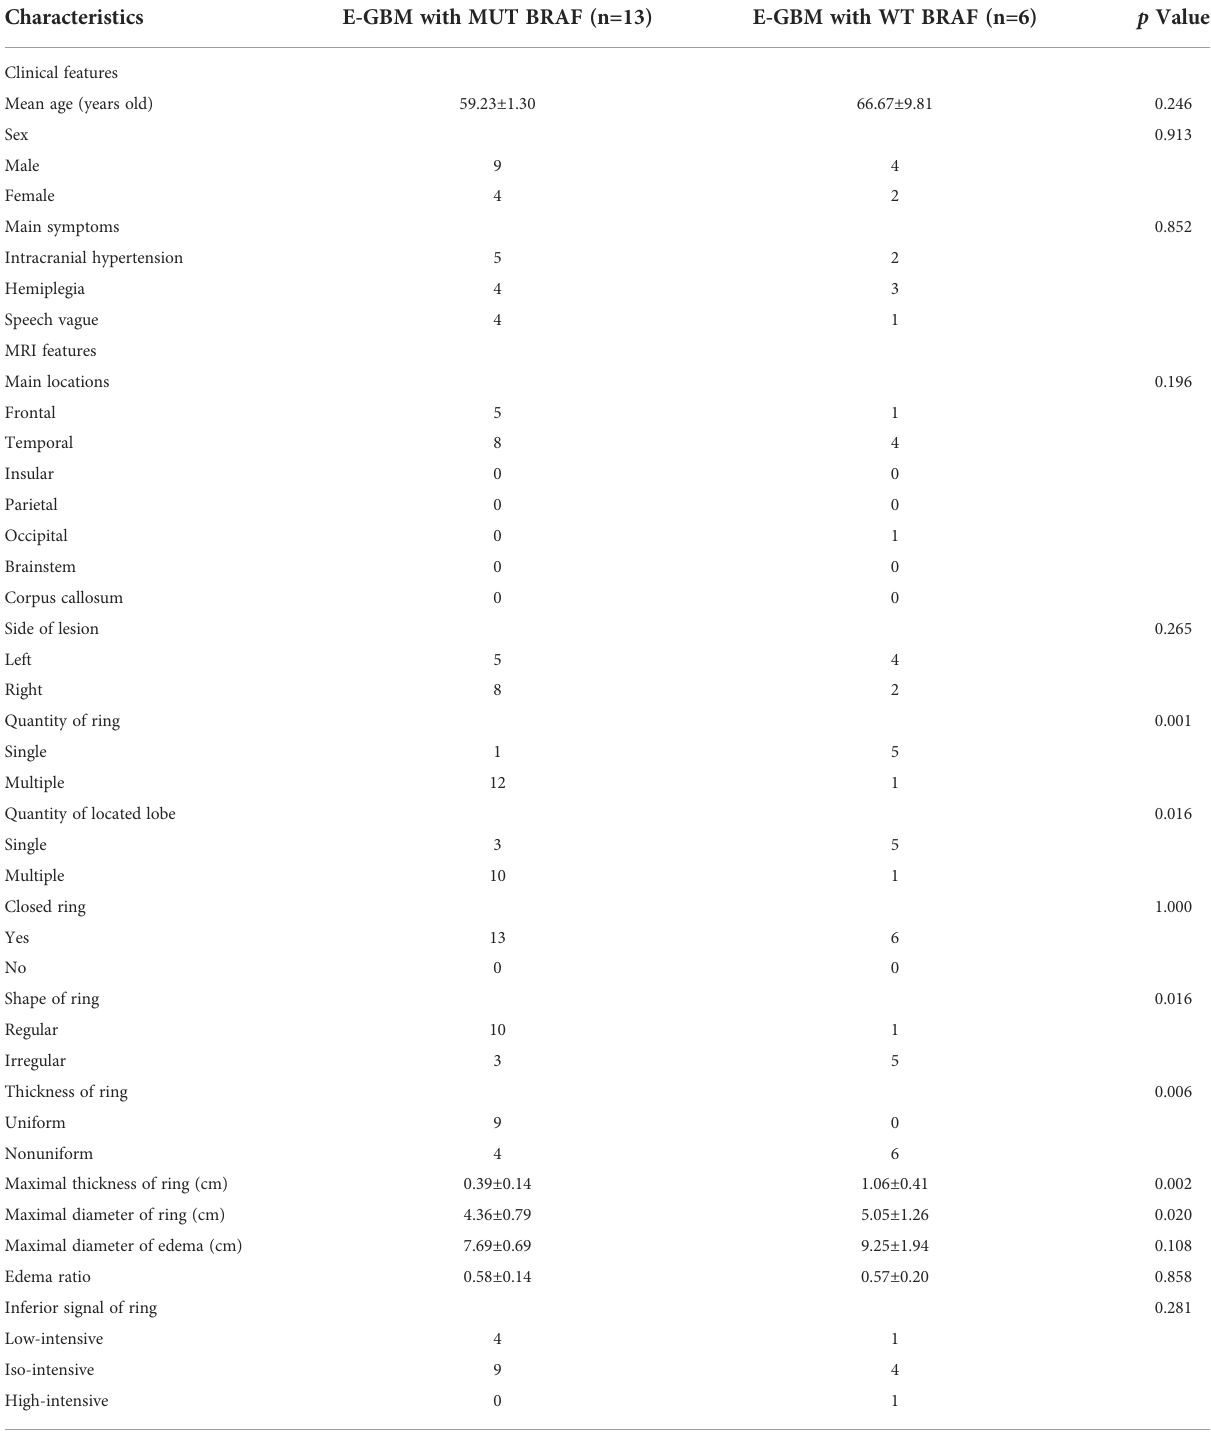
TABLE 4 Demographics and clinical characteristics of E-GBM cases strati fi ed by BRAF mutation